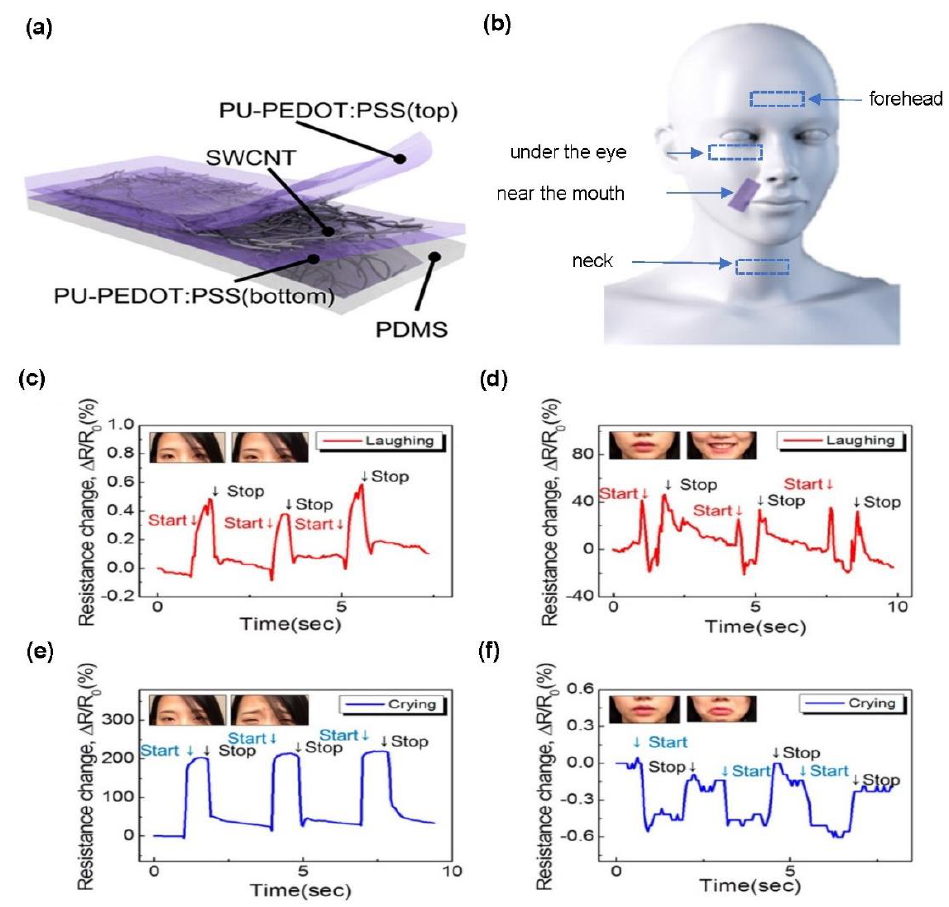
Figure 4. CNT-based strain sensor for facial expression recognition: ( a ) schematic illustration of the cross-section of the strain sensor showing the three-layer stacked structure of the polyurethane poly(3,4-ethylenedioxythiophene) polystyrenesulfonate (PU-PEDOT:PSS)/single-walled carbon nanotubes (SWCNTs)/PU-PEDOT:PSS composite elastomer on a PDMS substrate; ( b ) schematic illustration of stretchable transparent strain sensors attached to four different facial regions to sense skin strains by muscle movements during the expression of emotions; ( c – f ) time-dependent ∆ R/R0 responses of the sensor attached to ( c ) forehead and ( d ) skin near the mouth with the subject laughing, and of the sensor attached on the ( e ) forehead and ( f ) skin near the mouth with the subject crying. Reproduced with permission from Roh et al. [154], copyright 2015, American Chemical